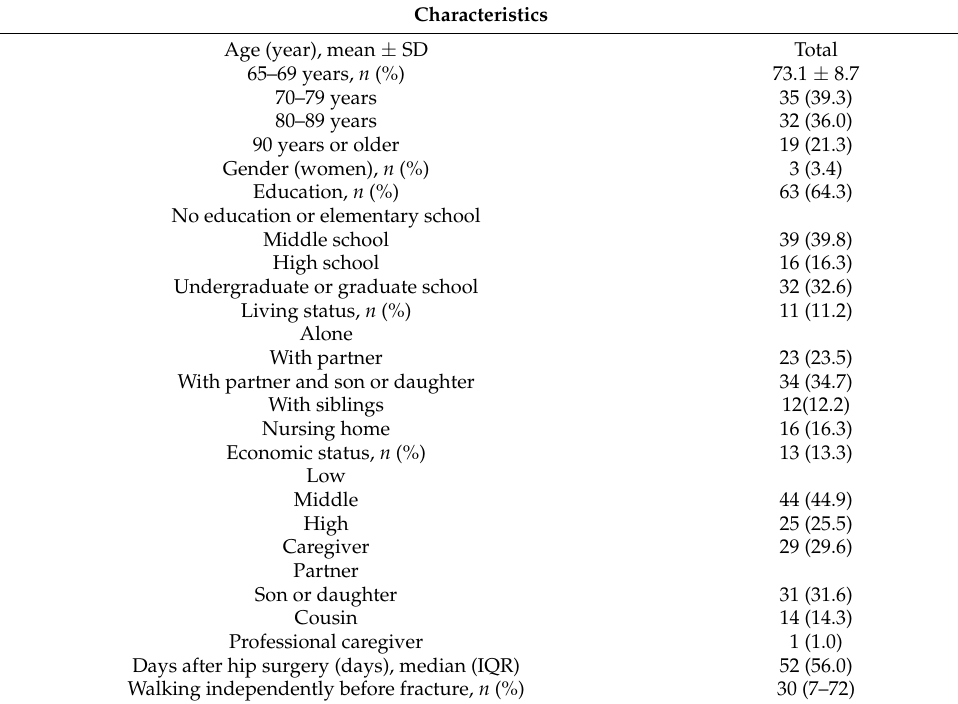
Table 1. General characteristics of the participants ( n = 98).